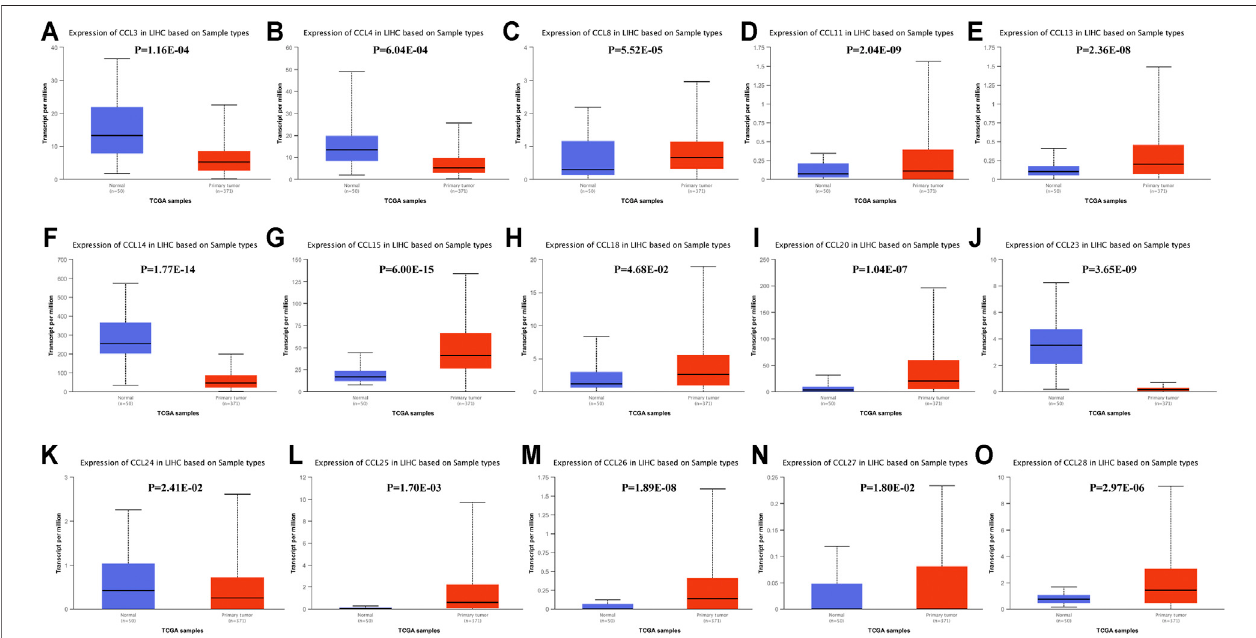
FIGURE2| Thetranscriptionlevels ofchemokinesCCLinLIHC (UALCAN). Thetranscriptional levels of (C) CCL8, (D) CCL11, (E) CCL13, (G) CCL15, (H) CCL18, (I) CCL20, (L) CXCL25, (M) CCL26, (N) CCL27, and (O) CCL28 in RCC tissues were signi fi cantly elevated while the transcriptional levels of (A) CCL3, (B) CCL4, (F) CCL14, (J) CCL23, and (K) CCL24 were remarkably reduced. p < 0.05 was considered statistically signi fi cant.